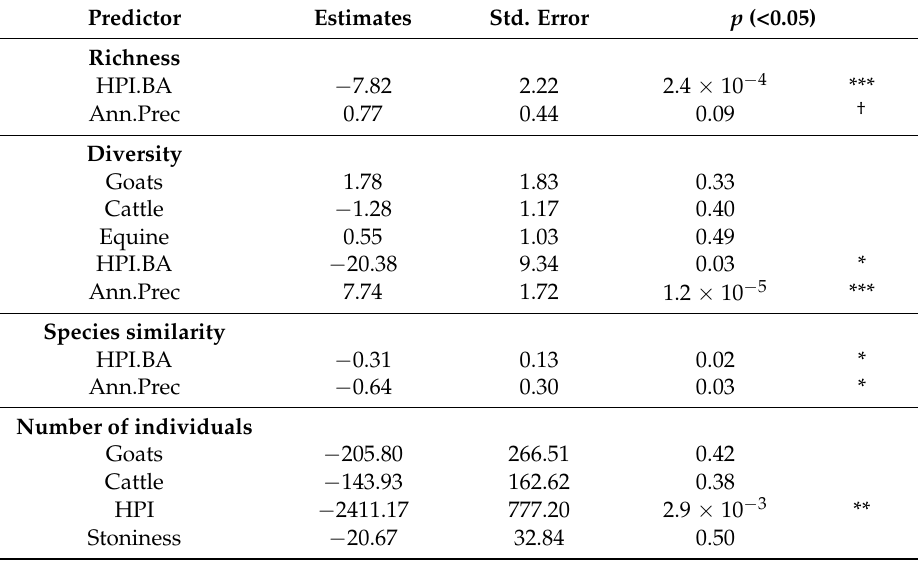
Table 3. Influence of predictors included in the best models on richness, diversity, species similarity, number of individuals, and basal area according to GLMM, n =